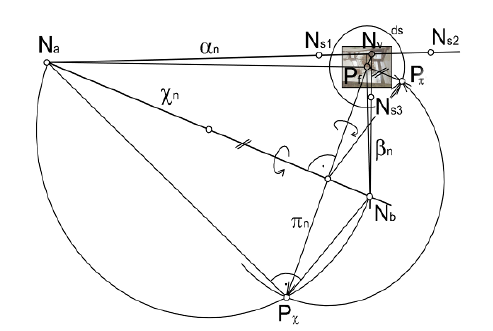
Figure 5. Principal point and focal length